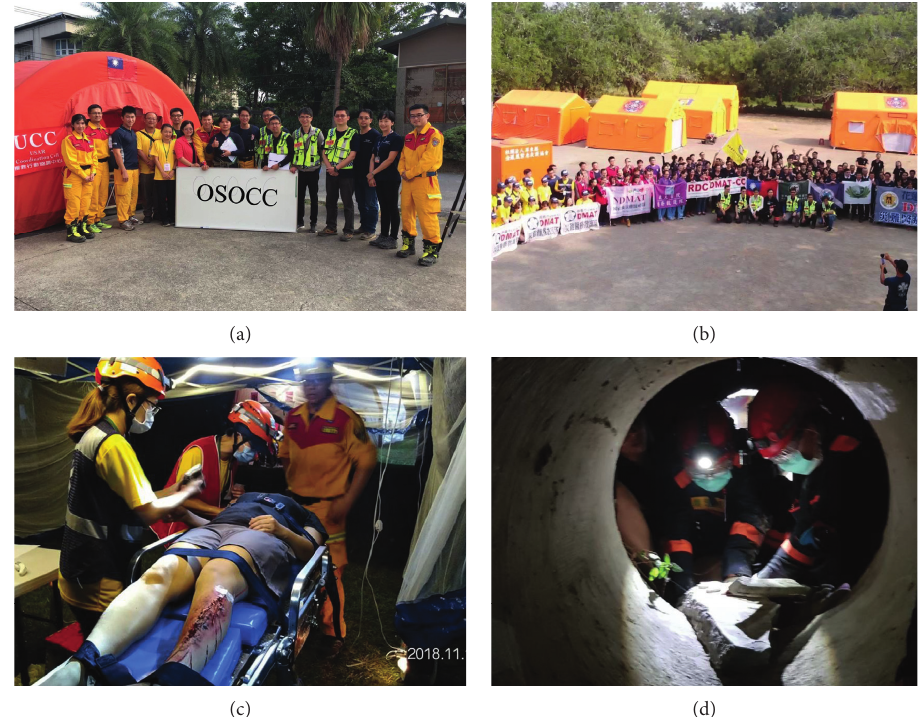
Figure 3: Photographs of the full-scale exercise. (a) Group photo of the core leader of each unit after the meeting at OSOCC; (b) group photo of DMATs in the base of operation; (c) part of the medical station in Scene B; (d) DMATdoctors performing emergency amputation surgery in a confined